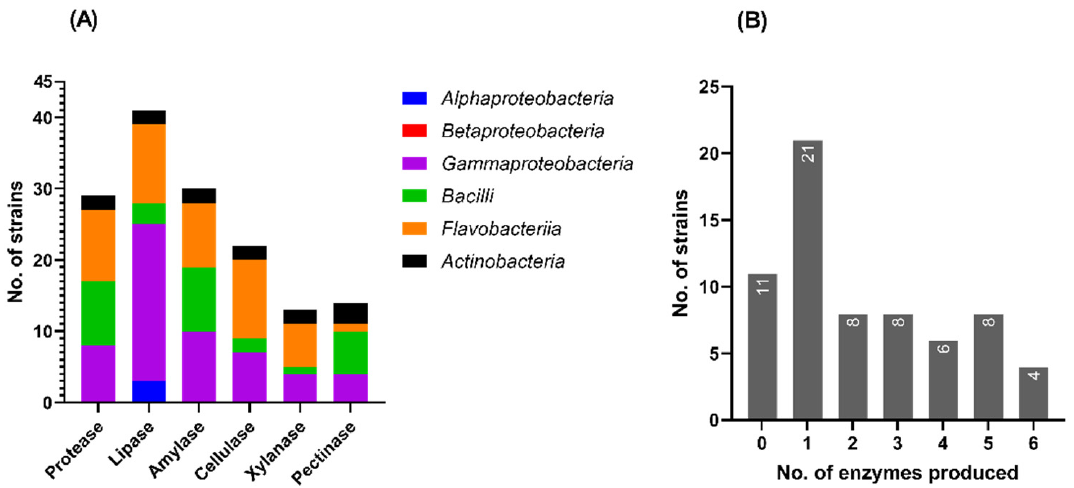
Figure 6. Hydrolytic activity profile of the Black Sea bacterial isolates. ( A ) Taxonomic distribution of different hydrolytic enzyme production; ( B ) distribution of strains exhibiting a particular number of extracellular hydrolases.